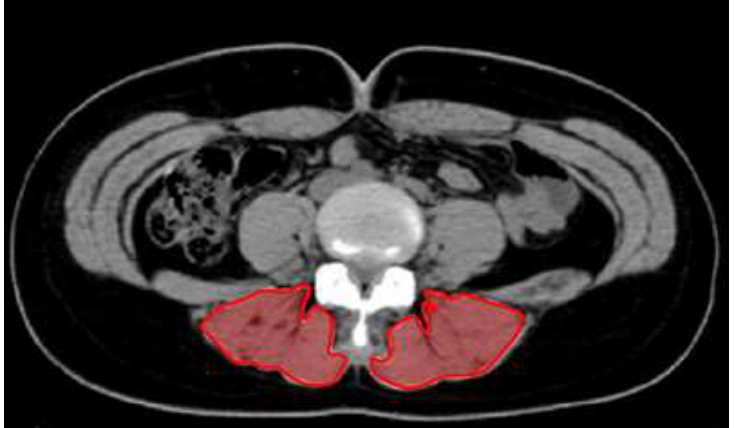
Figure 2. Computed tomography measurement of the cross-sectional area of the paraspinal lumbar muscle.